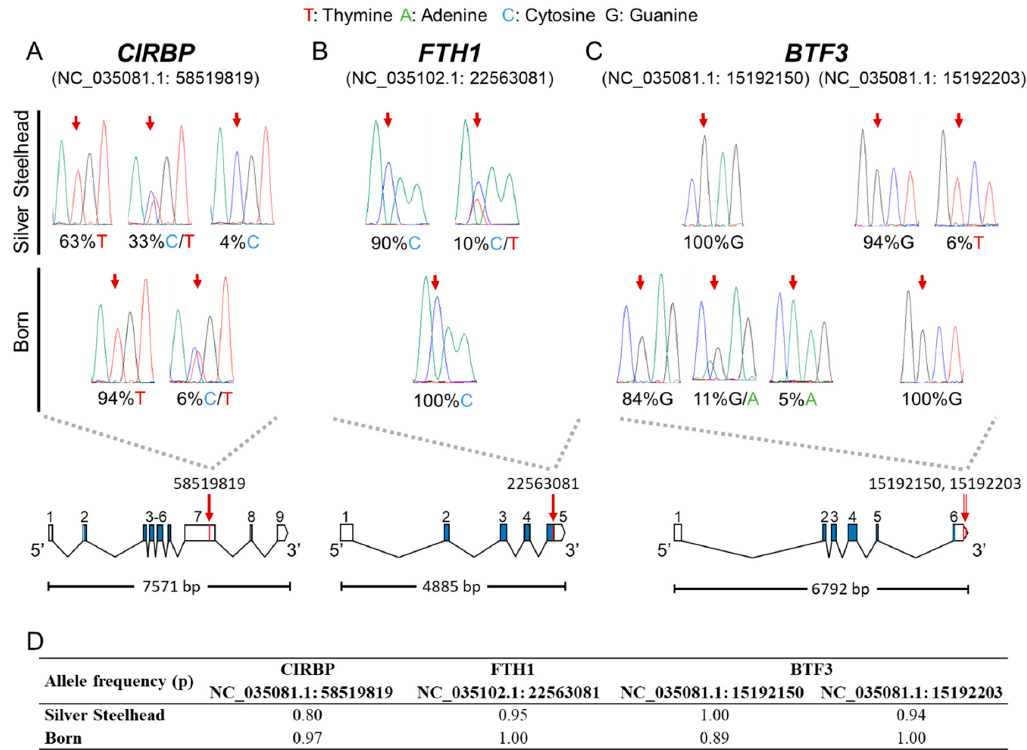
Figure 5. Validation and genomic location of four putative SNPs in rainbow trout strains Silver Steelhead and Born. Sequencing results are displayed by electropherograms (upper panel) showing the frequency of the sequence variants in the genes ( A ) CIRBP (NC_035081.1: 58519819), ( B ) FTH1 (NC_035102.1: 22563081), ( C ) and BTF3 (NC_035081.1: 15192150, NC_035081.1: 15192203). The lower panel displays the location of the SNPs (red dashes and arrows) in the respective gene structure. Exons are drawn by scaled boxes, and introns are shown as scaled lines. The coding region is highlighted in blue and the total transcript length is given under the gene structure. ( D ) Strain-specific allele frequency (p) for the validated SNPs.